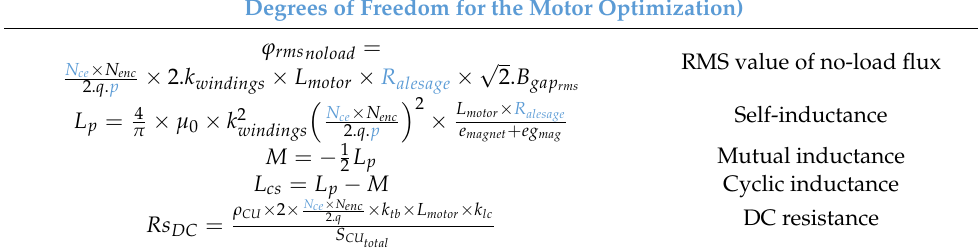
Table 7. Electric circuit parameter computation. Electric Circuit Parameters (in Blue is the Set of Decision Variables which Constitute the Degrees of Freedom for the Motor Optimization) ϕ rmsnoload = N ce N enc × 2. q .